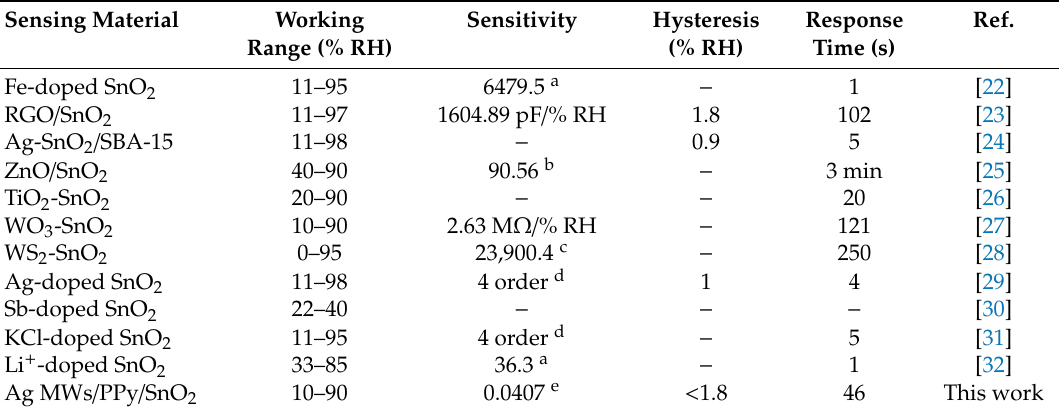
Table 2. Humidity sensor performance of this work compared with the literatures based on the SnO 2 -based humidity